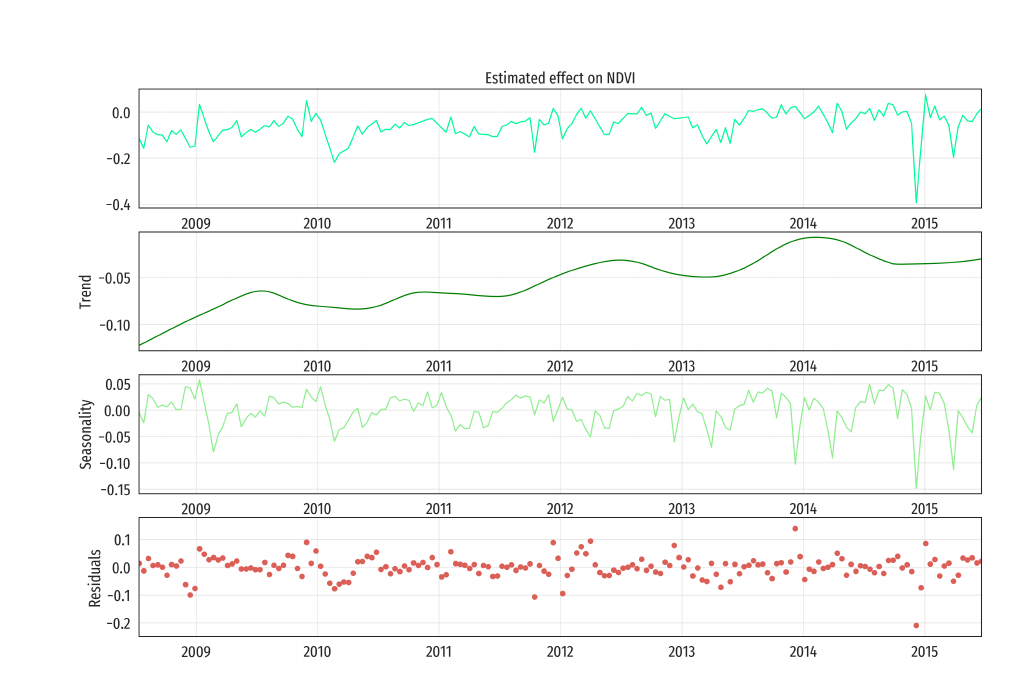
Figure 4. Plot of time series decomposition using LOcally Estimated Scatterplot Smoothing (LOESS) of the MEU LIGHTNING COMPLEX (MIDDLE) wildfire. The four graphics show, from top to bottom, the estimated wildfire effect, the extracted trend, the seasonal component, and the residuals.